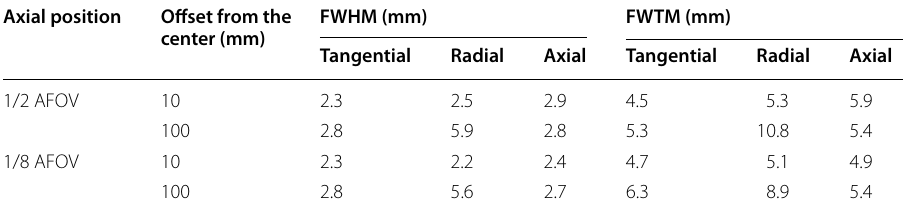
AFOV axial field of view, FWHM full width at half maximum, FWTH full width at one‑tenth of the maximum